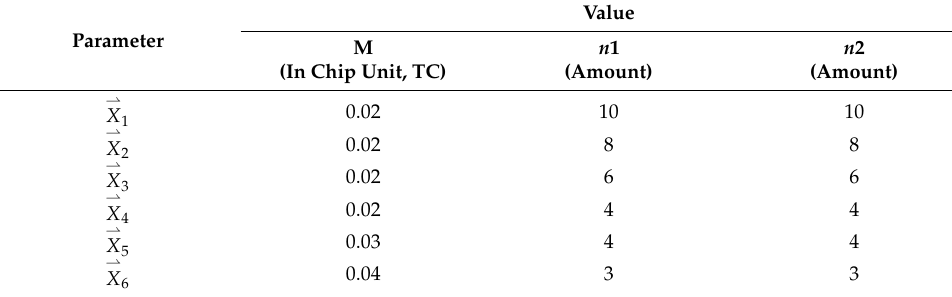
Table 2. Parameter configuration of eigenvectors.